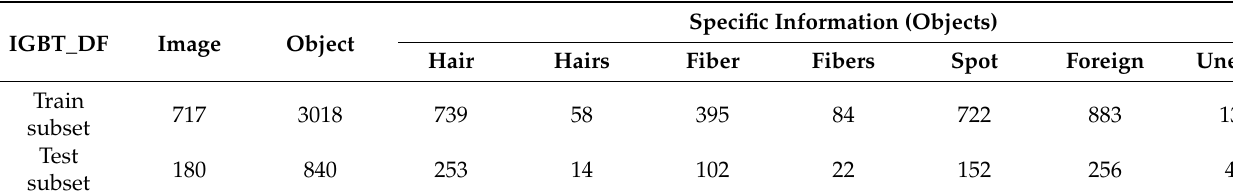
Table 2. The specific information of IGBT_DF dataset.